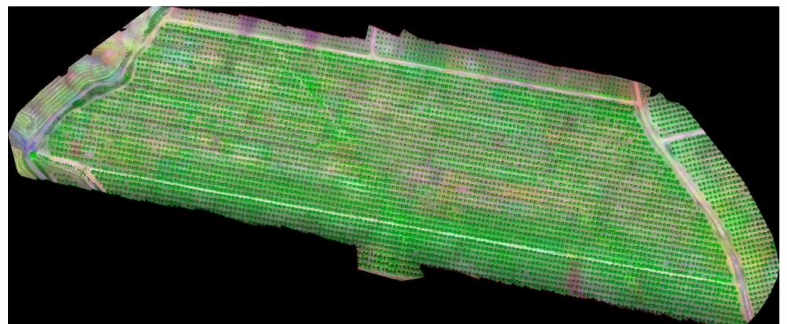
Figure 4. Colour image generated from the information provided by the orthomosaics of the Blue, Red Edge and NIR spectral